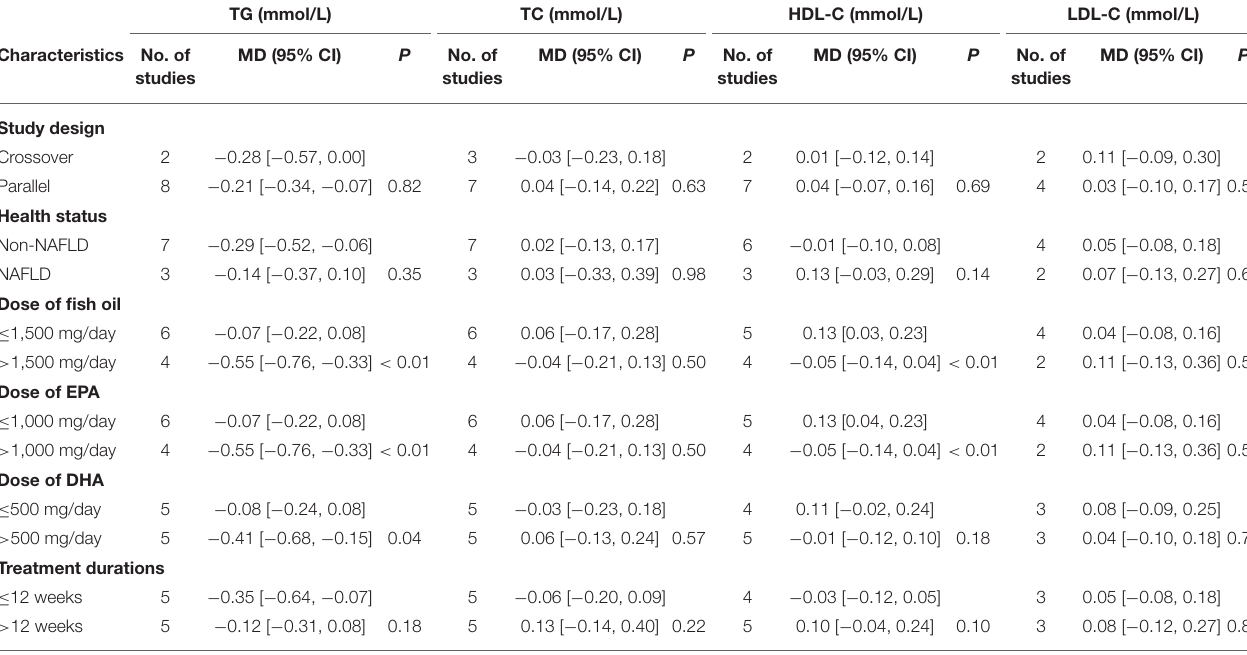
TABLE 5 | Subgroup analyses for the outcomes of blood lipids.